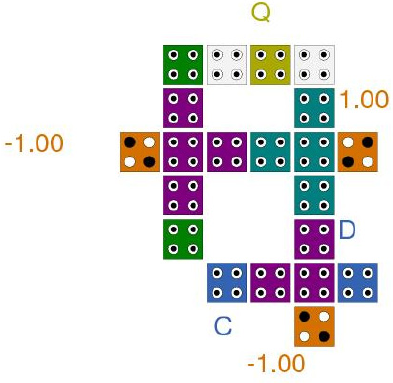
Figure 8. QCA implementation of proposed DFF design.